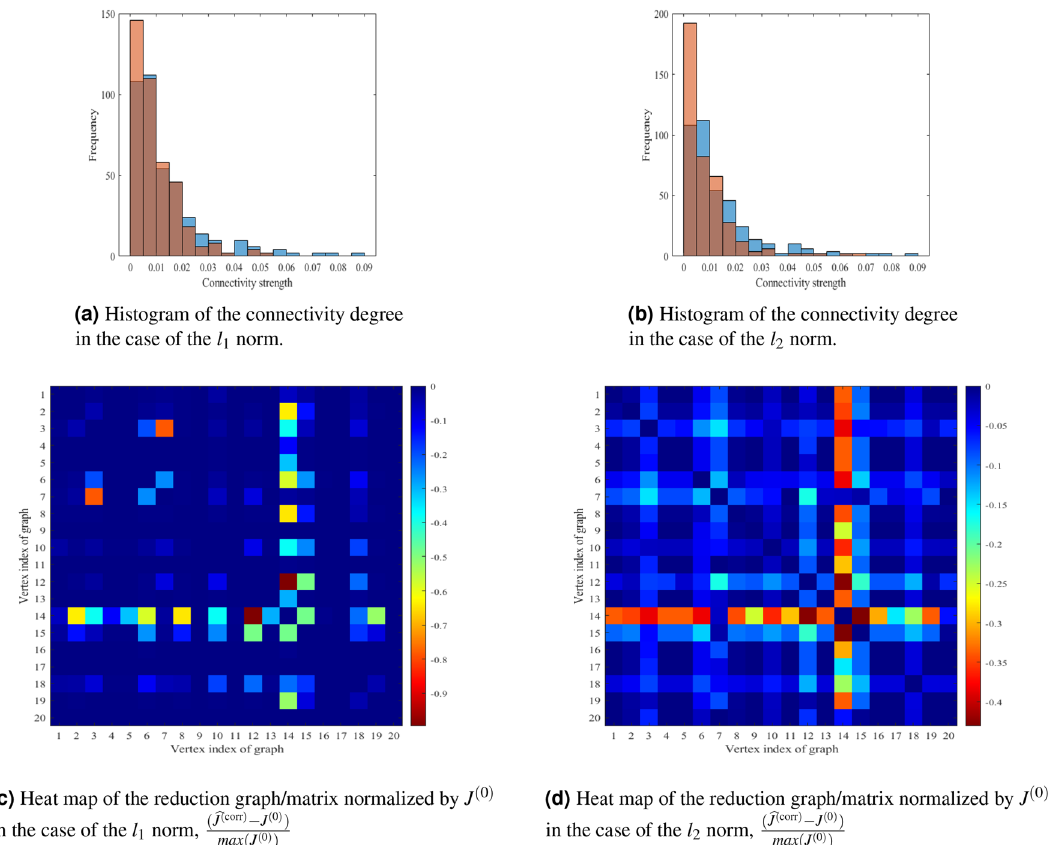
Figure 6. Sub-figure ( a ) and Sub-figure ( b ), correspondent to l 1 and l 2 cases respectively, present histogram of the connectivity degree of the infected instance (blue) and corrected instance (orange) for the case of the Seattle city shown in Fig. 5. Sub-figure ( c ) and Sub-figure ( d ) show the heat-map representation of the reduction graphs 0 ) normalized by J ( from the middle layers in Fig. 5, where color coding of the ( i , j ) element of the symmetric 20 × 20 matrix is chosen proportional to (